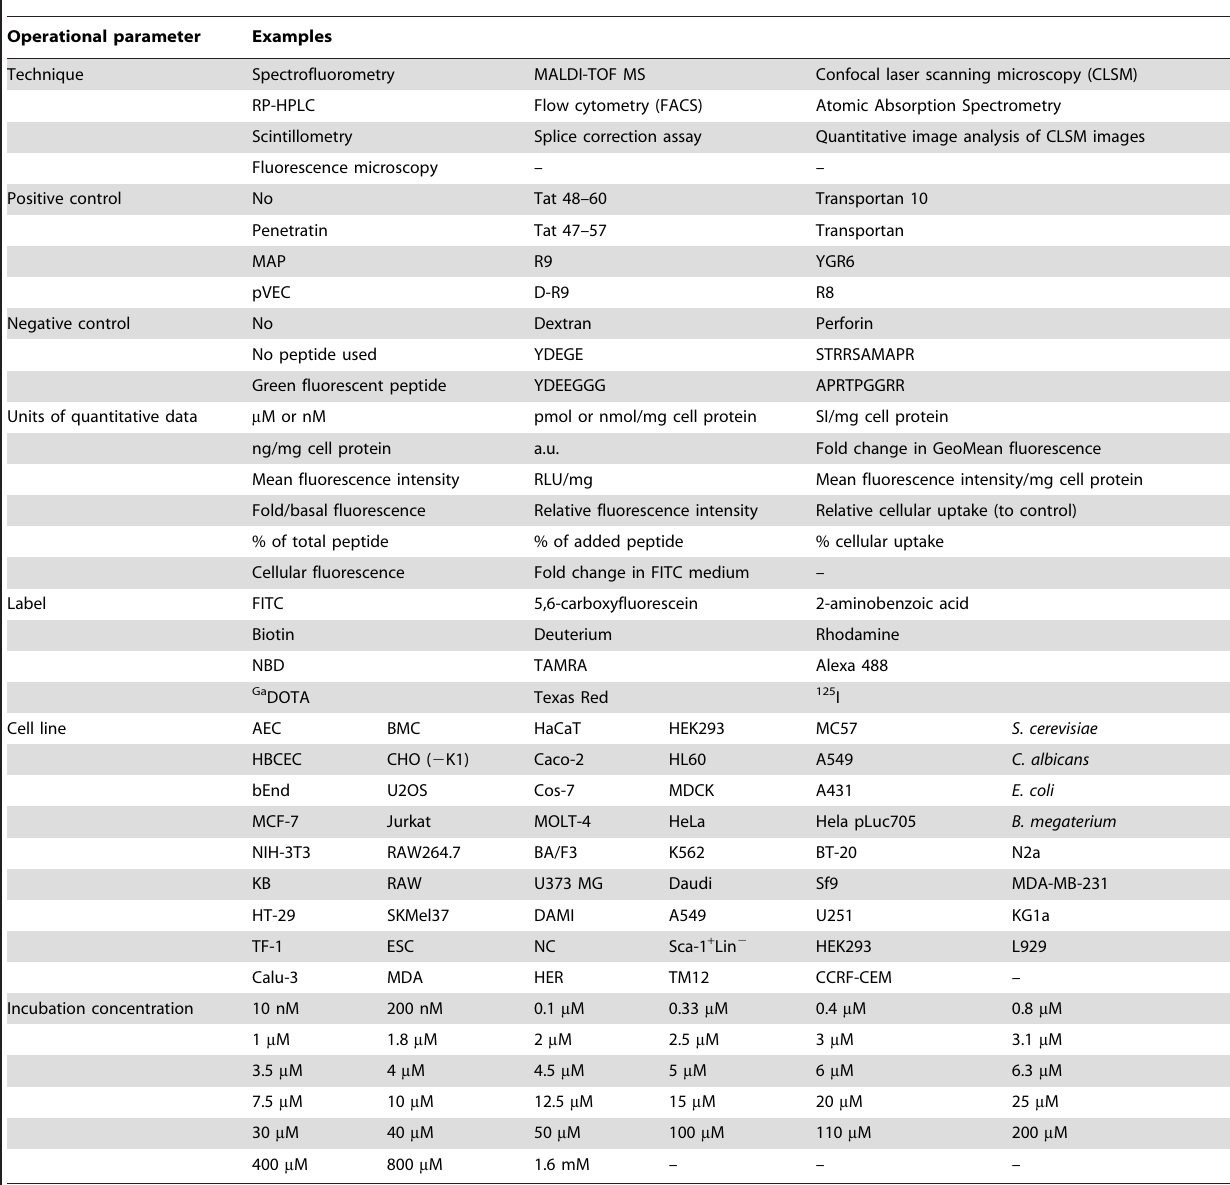
Table 1. Experimental differences between studies for cellular uptake of